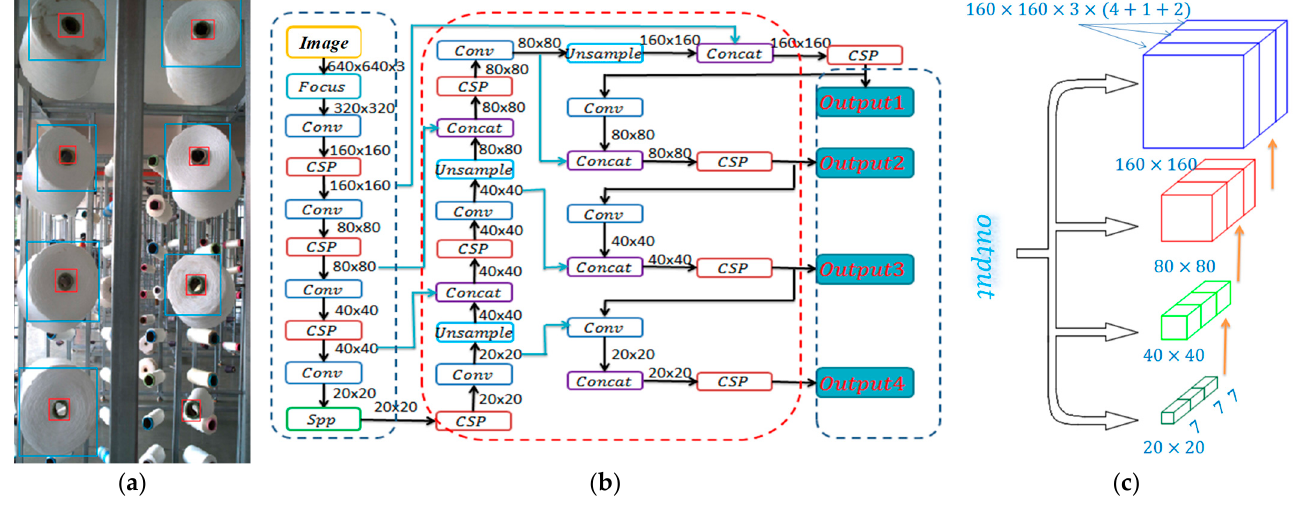
Figure 3. Yolo model. ( a ) Training sample. ( b ) The structure of network. ( c ) Model’s outputs.